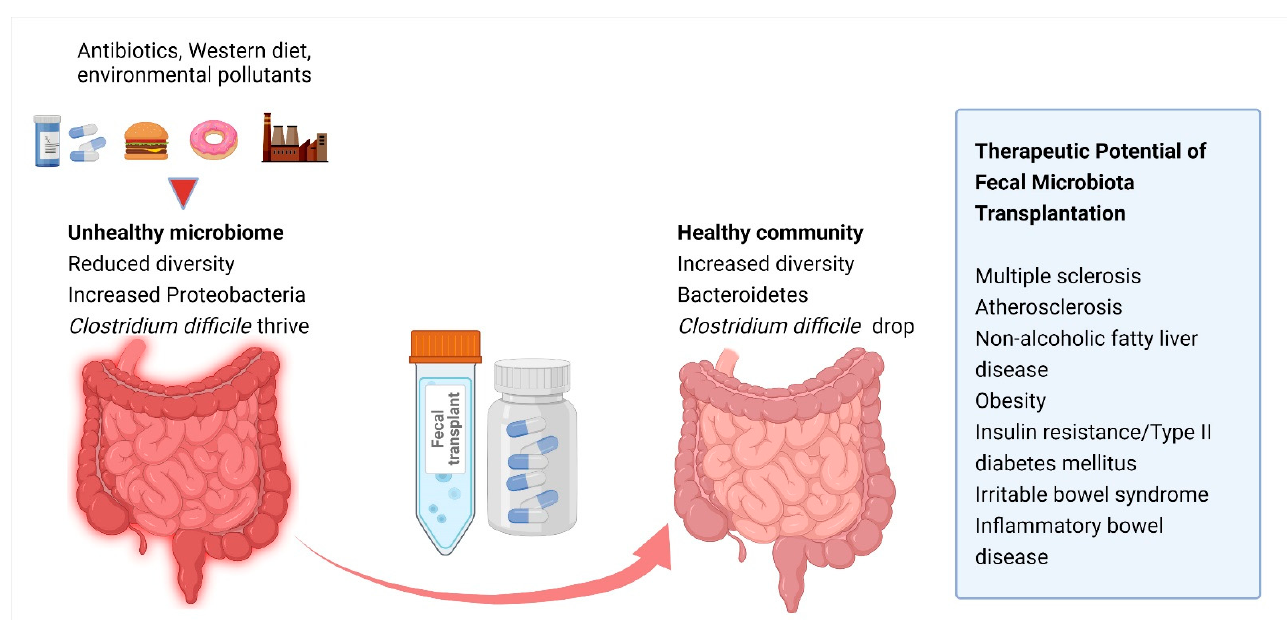
Figure 4. Beneficial effects of fecal microbiota transplantation. The concept of fecal transplantation is represented by the transfer of beneficial bacteria from the stools of a healthy donor to a patient with a disease caused by dysbiosis of their gut microbiota, in order to increase microbial diversity. Created with BioRender.com (Last accessed on 21 July 2021).